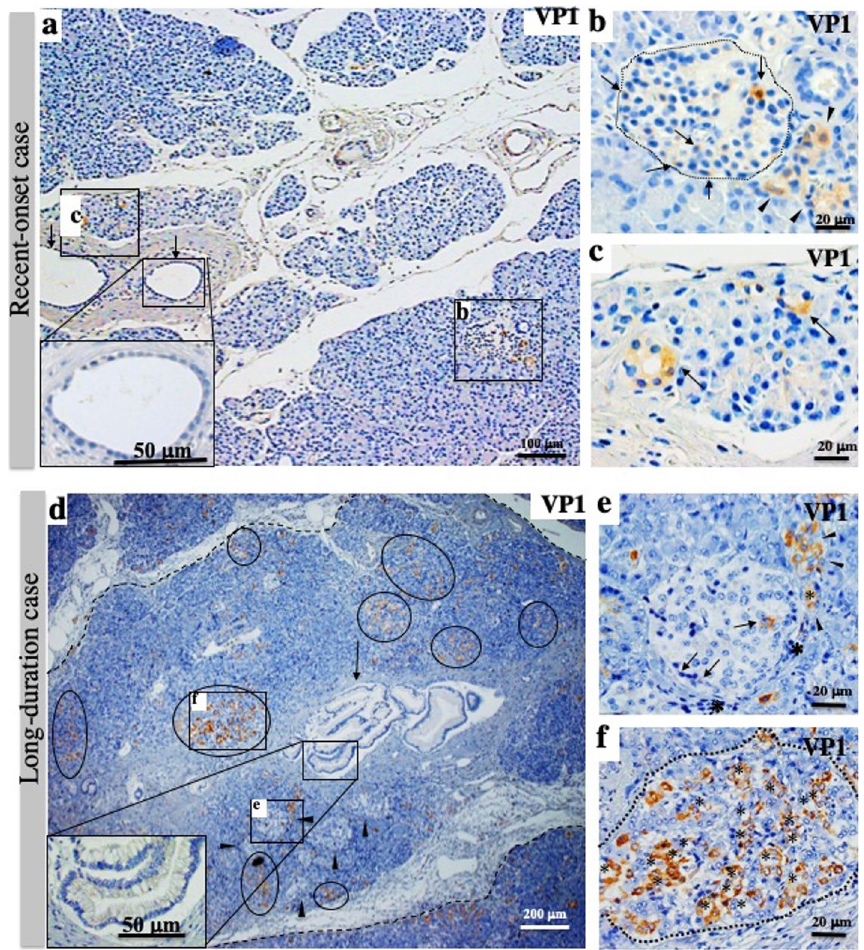
Figure 1. Enterovirus (EV) infection of islets and exocrine pancreas in recent-onset diabetes and long-duration diabetes of slowly progressive type 1 diabetes mellitus (SPIDDM). (a) Low-magnification view of the pancreas in recent-onset diabetes (Case SP10; duration: 3 months), stained for VP1. Islet cells ( b ) and exocrine cells ( c ) are positive for EV capsid protein (VP1, brown). VP1-positive acinar cells are rarely found. Inset: pancreatic duct epithelial cells (arrows) are intact, without features of pancreatic intraepithelial neoplasia (PanIN). ( b ) Magnified view of ( b ). Some islet cells (arrows) and acinar cells beside the islet (arrowheads) are positive for VP1. ( c ) Magnified view of ( c ). Two acini (arrows) show “ring-like” arrangements, reminiscent of the start of acinar-to- ductal-metaplasia (ADM). ( d) Low-magnification view of the pancreas with a long duration of SPIDDM (Case SP8; duration: 14 years) stained for VP1. A PanIN (arrow and inset)-centered lobe demarcated by fibrous tissue (dashed lines) includes many islets, one of which is marked with (e), and VP1-positive exocrine acinar cells constitute clusters (circled), one of which is marked with ( f ). Note that parenchymal tissues in the PanIN lobe demarcated by a dashed line are atrophied due to fibrosis and contain a relatively increased number of islets (arrowheads). ( e ) Magnified view of ( e ) in ( d ). Islet cells are positive for VP1 (arrows) surrounded by infiltrated mononuclear cells (asterisks). Note that the VP1-positive acinar cell cluster (arrowhead) touches the islet, suggesting close association with the islet. ( f ) Magnified view of ( f ) in ( d ). Most exocrine VP1-positive acinar cells (brown, asterisks) show a flat shape with ring-like arrangements, a feature of